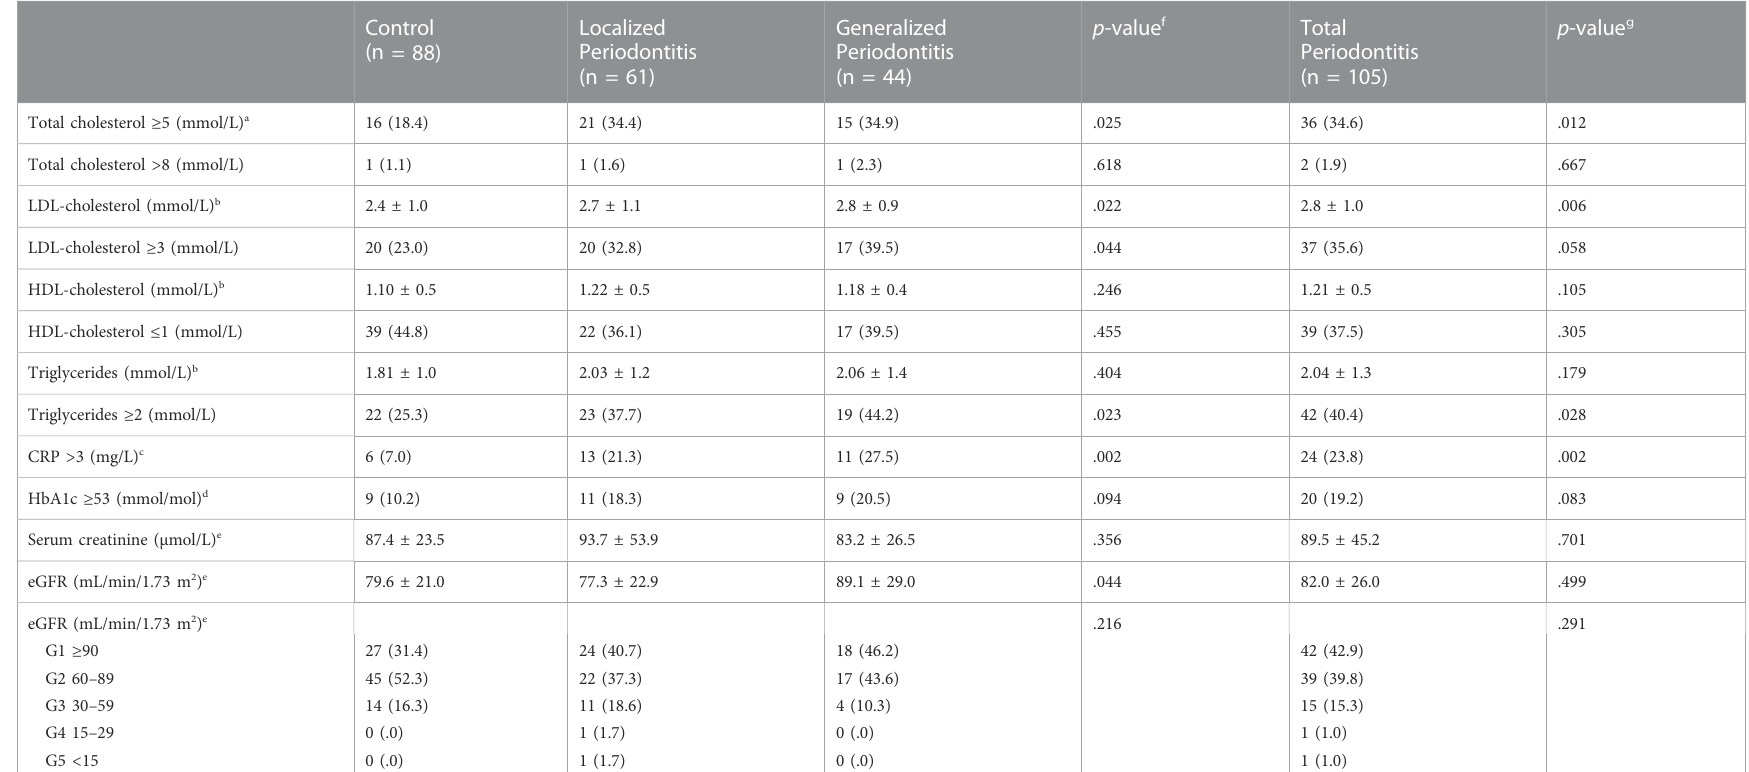
TABLE 5 Results of measured biochemical